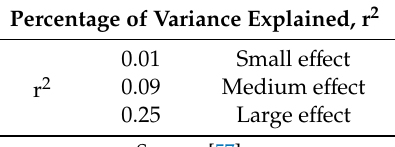
Table 3. Interpretation of the E ff ect Size Values r 2